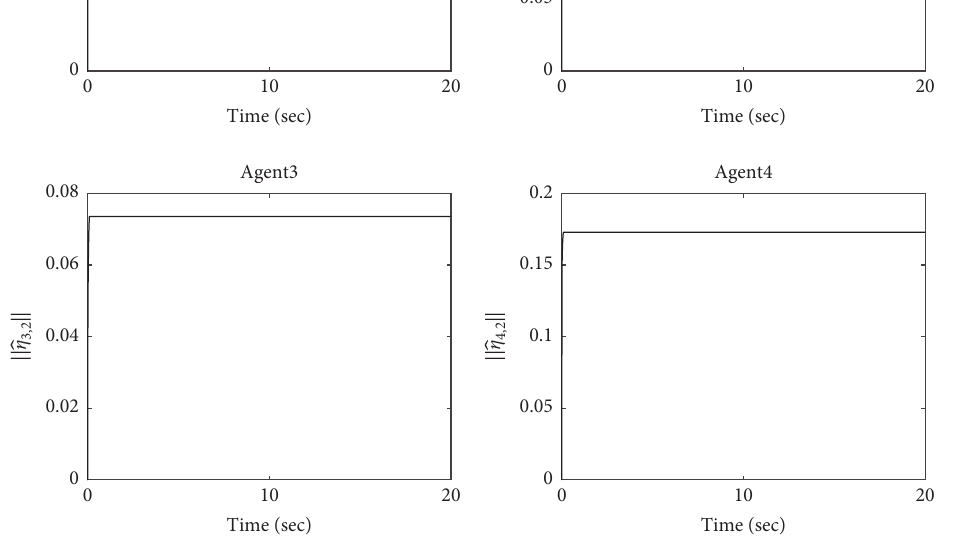
Figure 8: Trajectories of ‖ 􏽢 η